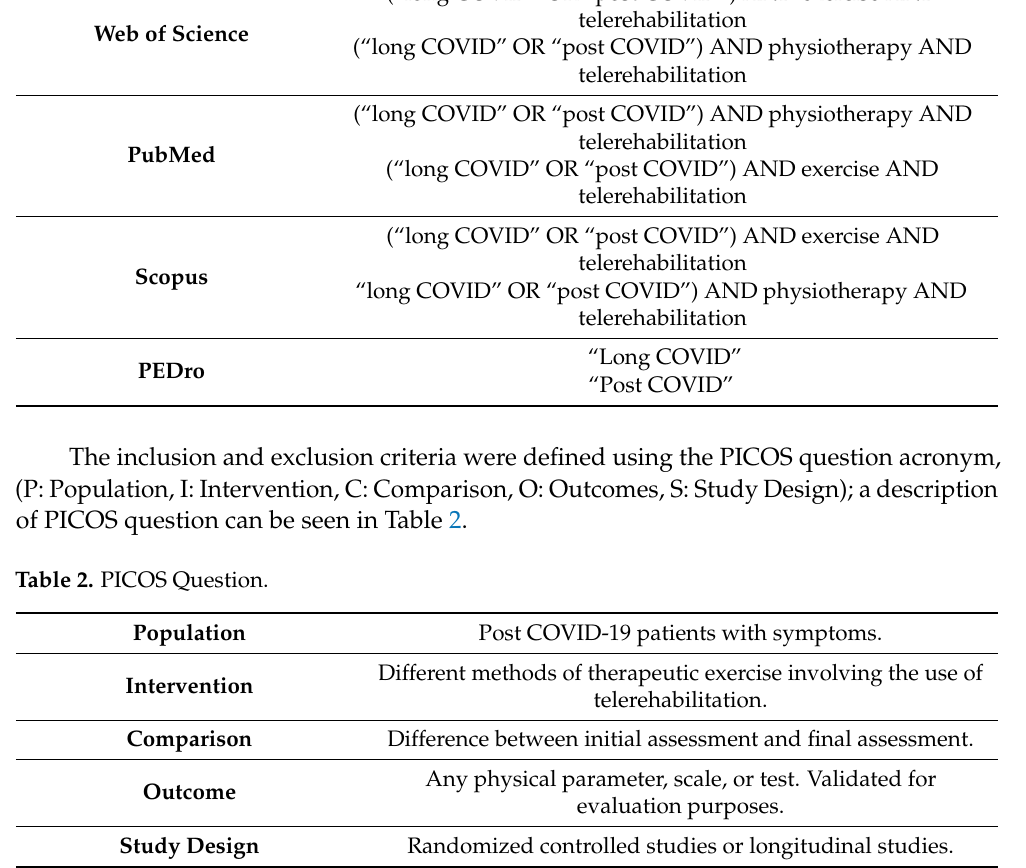
Table 1. Search Strategy. (“long COVID” OR “post COVID”) AND exercise AND Web of Science